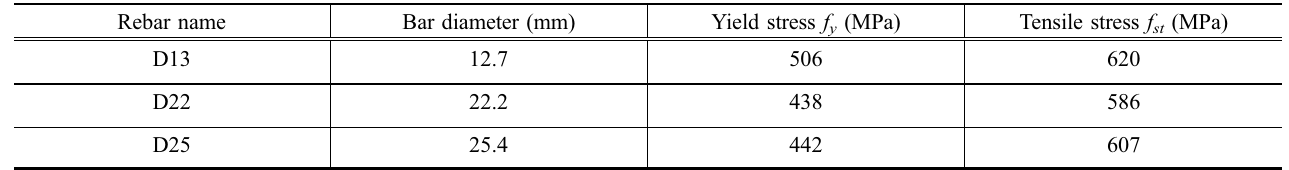
Fig. 7 Tensile stress–strain curves of steel. Table 5 Mechanical properties of reinforcing bars.